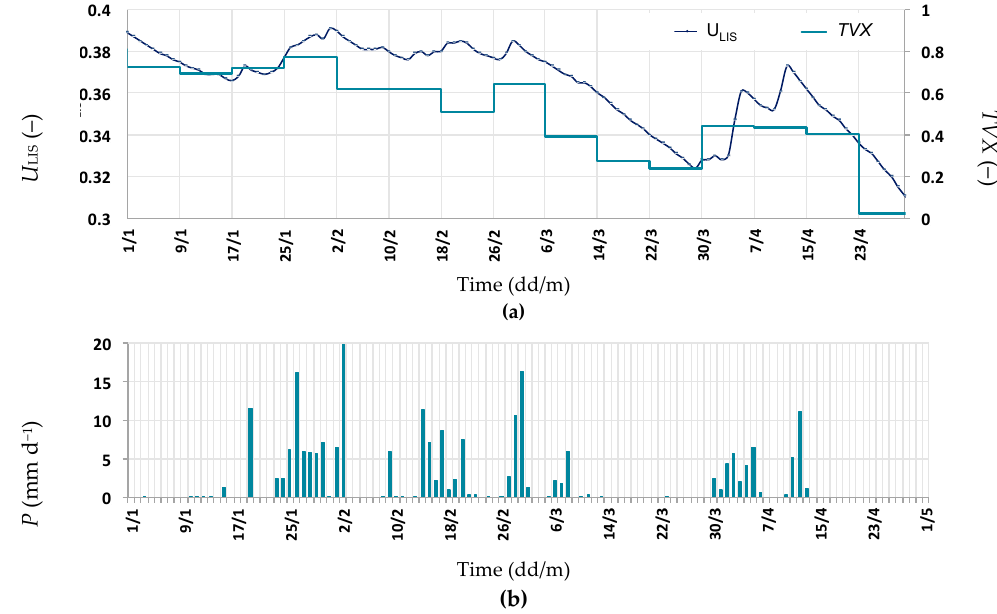
Figure 13. ( a ) Temporal behavior of U LIS (principal axis, black line) and TVX (secondary axis, indigo line) from 1st of January 2005 to the 1st of May 2005; ( b ) total daily rainfall at Drasi gauge